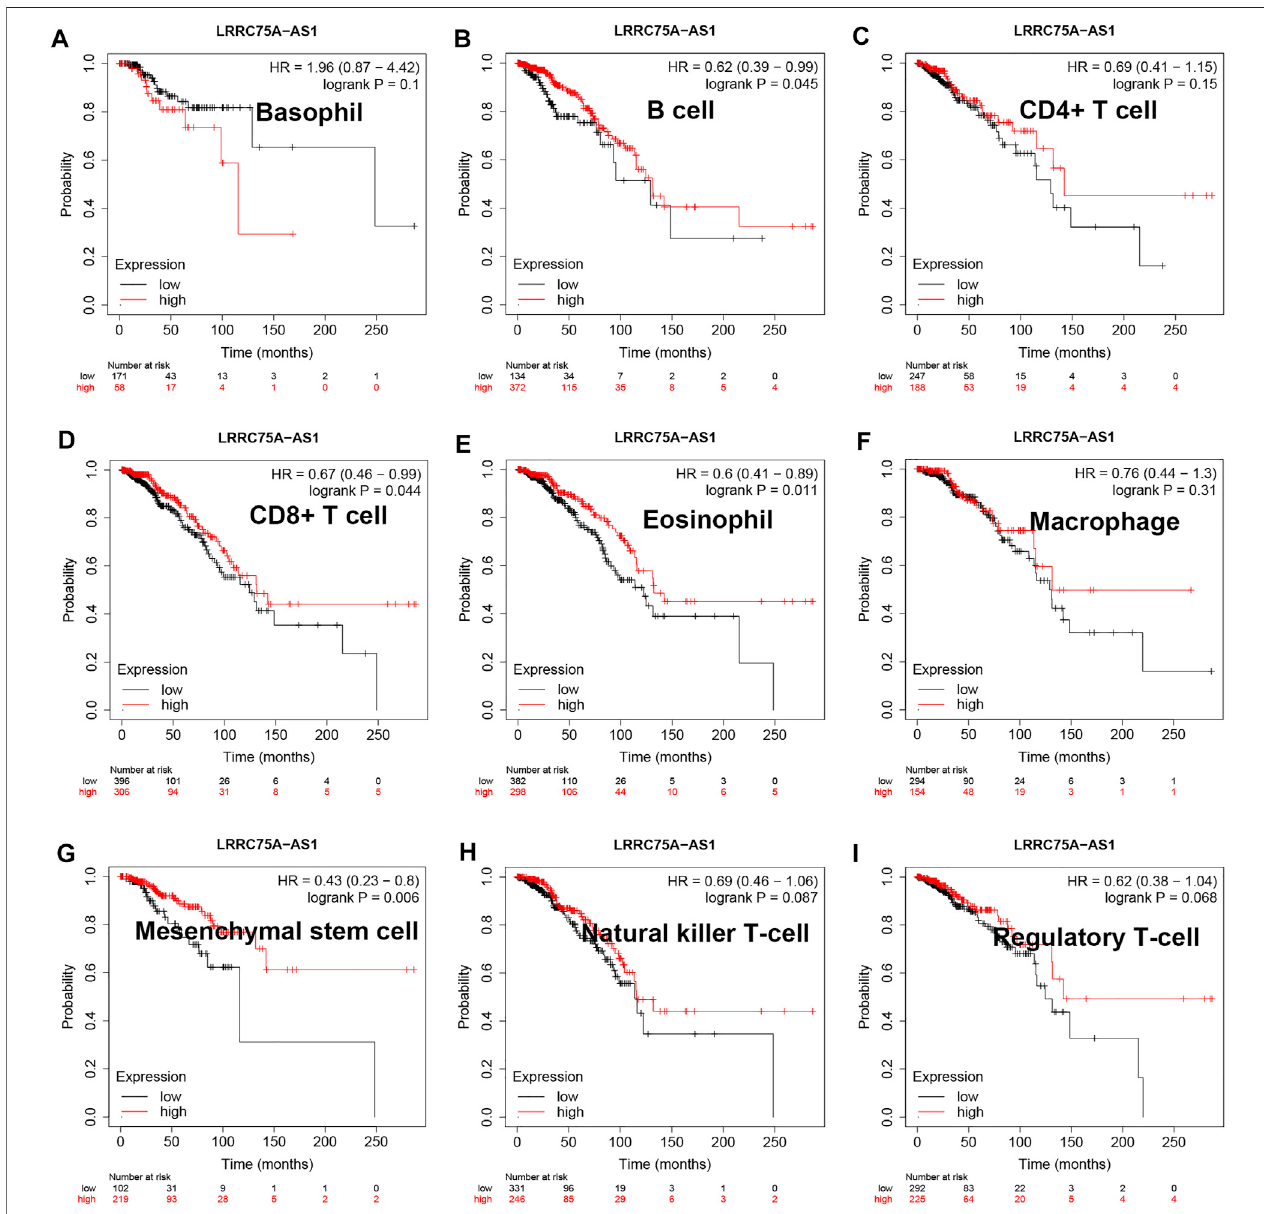
FIGURE 3 | Survival analysis for LRRC75A-AS1 in breast cancer decreased with various immunocyte. (A) The prognostic value of LRRC75A-AS1 in basophil- decreased breast cancer. (B) The prognostic value of LRRC75A-AS1 in B cell-decreased breast cancer. (C) The prognostic value of LRRC75A-AS1 in CD4 + cell- decreased breast cancer. (D) The prognostic value of LRRC75A-AS1 in CD8 + cell-decreased breast cancer. (E) The prognostic value of LRRC75A-AS1 in eosinophil- decreased breast cancer. (F) The prognostic value of LRRC75A-AS1 in macrophage-decreased breast cancer. (G) The prognostic value of LRRC75A-AS1 in mesenchymal stem cell-decreased breast cancer. (H) Theprognostic value ofLRRC75A-AS1 in natural killer T cell-decreasedbreast cancer. (I) The prognostic valueof LRRC75A-AS1 in regulatory T cell-decreased breast cancer.